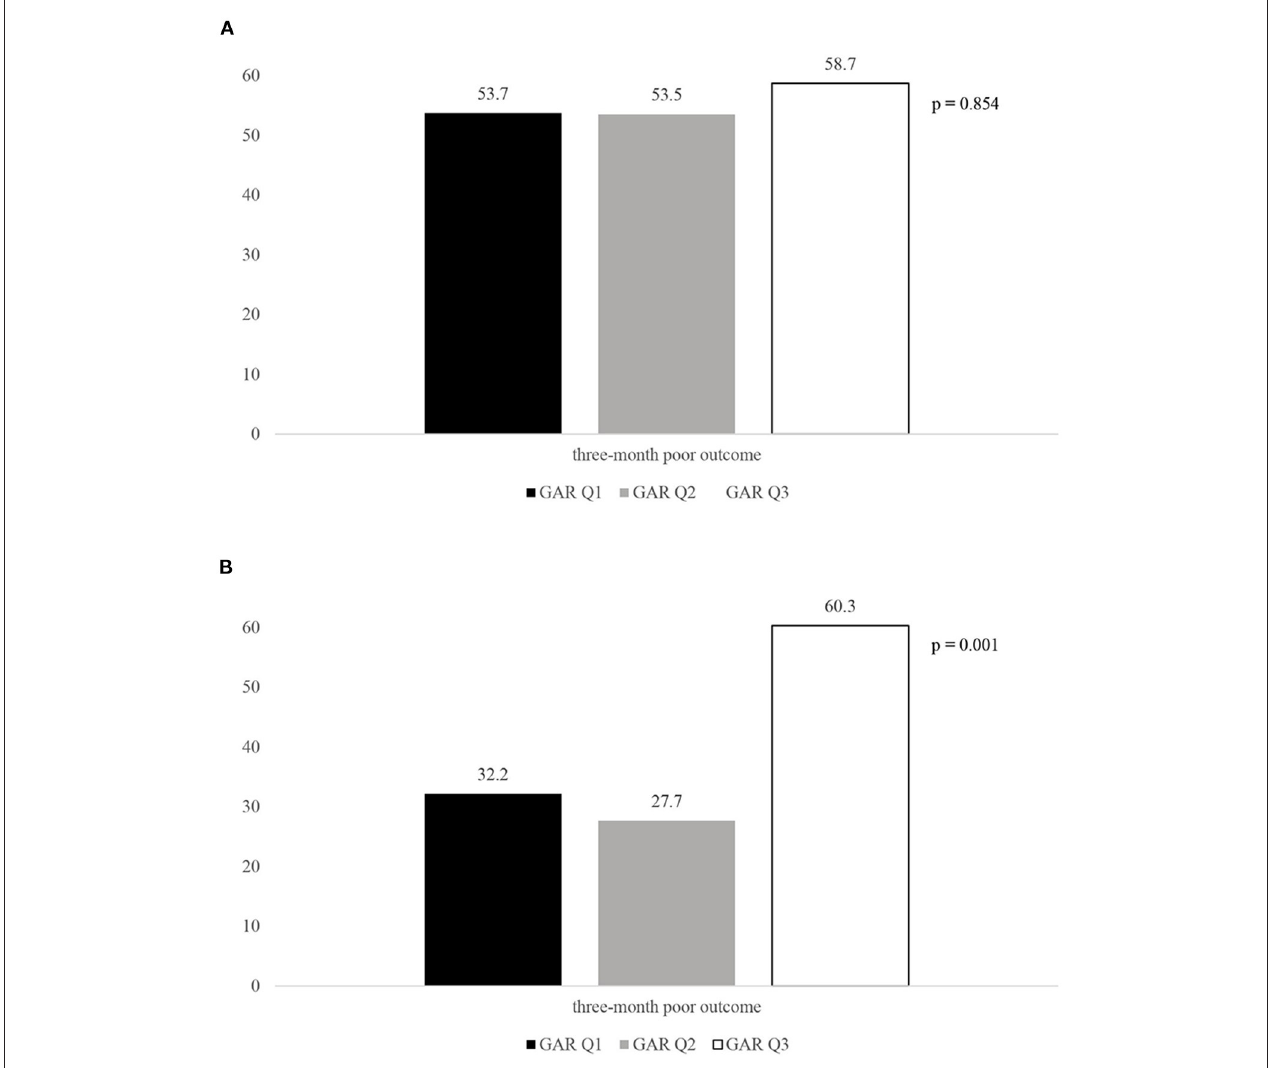
FIGURE 2 | Rates of three-month poor outcome according to the GAR tertiles in diabetic. (A) and non-diabetic patients (B) . GAR Q1, first glucose-to-glycated hemoglobin ratio tertile; GAR Q2, second glucose-to-glycated hemoglobin ratio tertile; GAR Q3, third glucose-to-glycated hemoglobin ratio